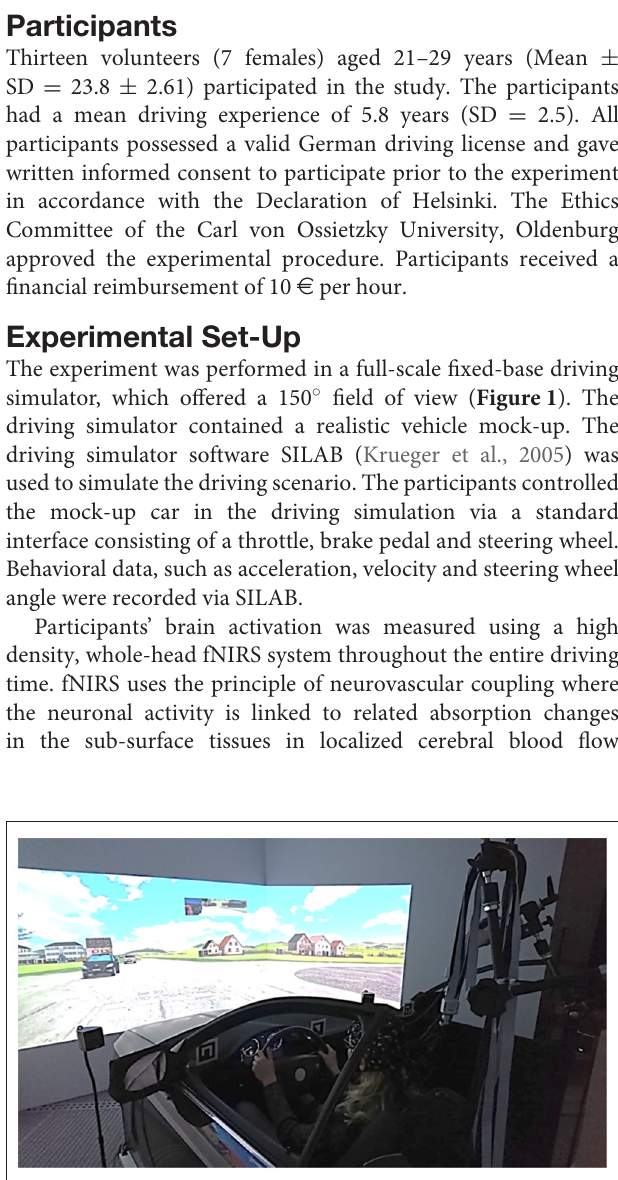
FIGURE 1 | Virtual reality lab driving simulator at OFFIS Institute of Information Technology, Oldenburg—photograph of experimental setup. The participant’s brain activity is measured with whole-head fNIRS system while they are driving in the urban